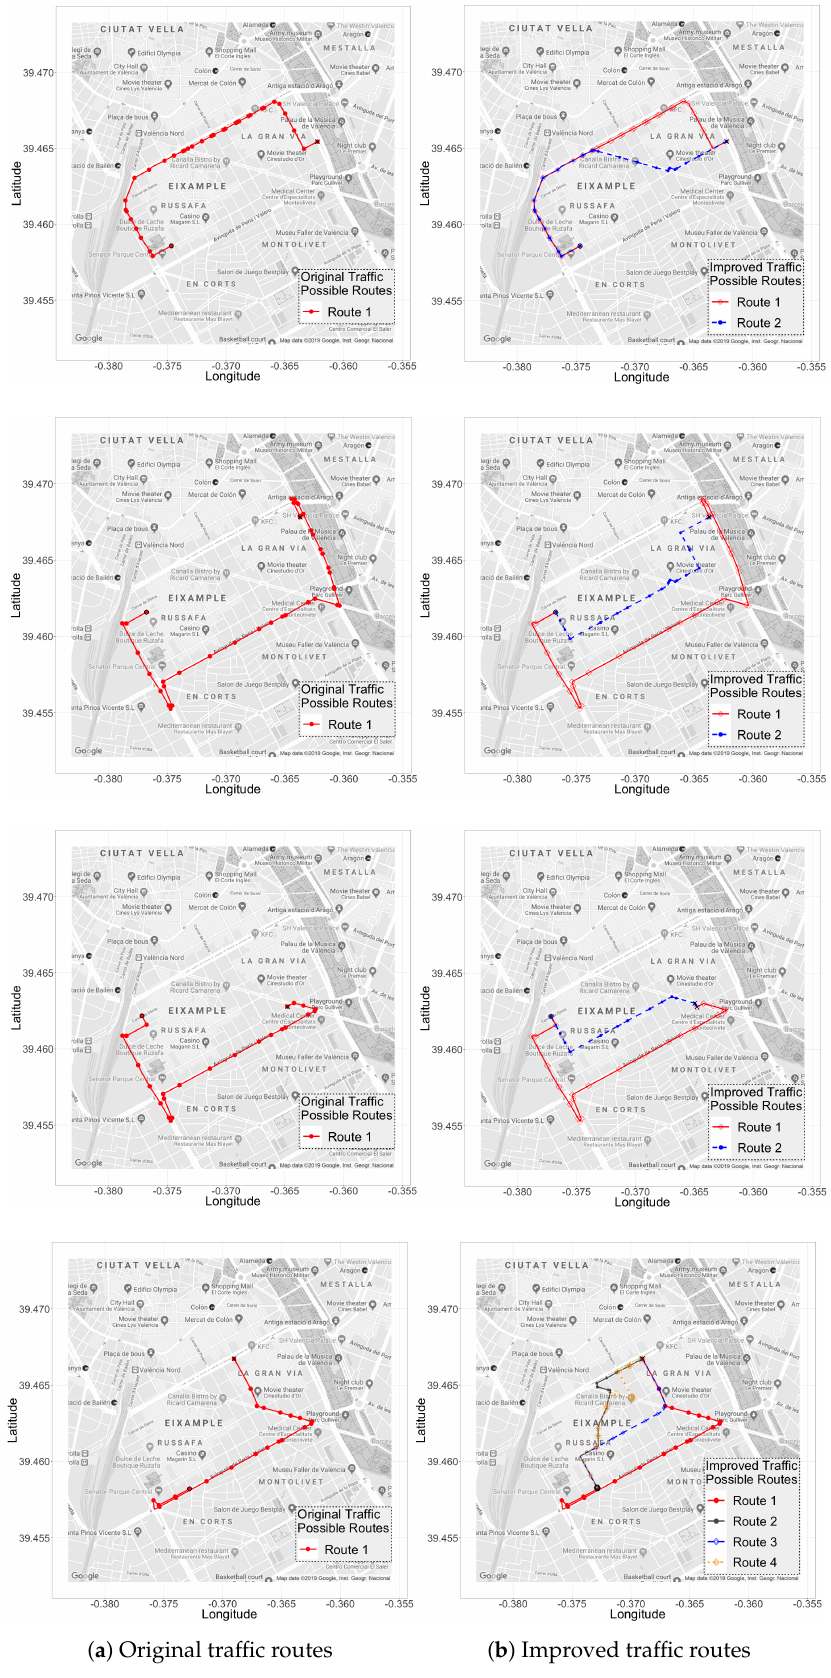
Figure 10. Routes Origin-Destination of the original traffic and our